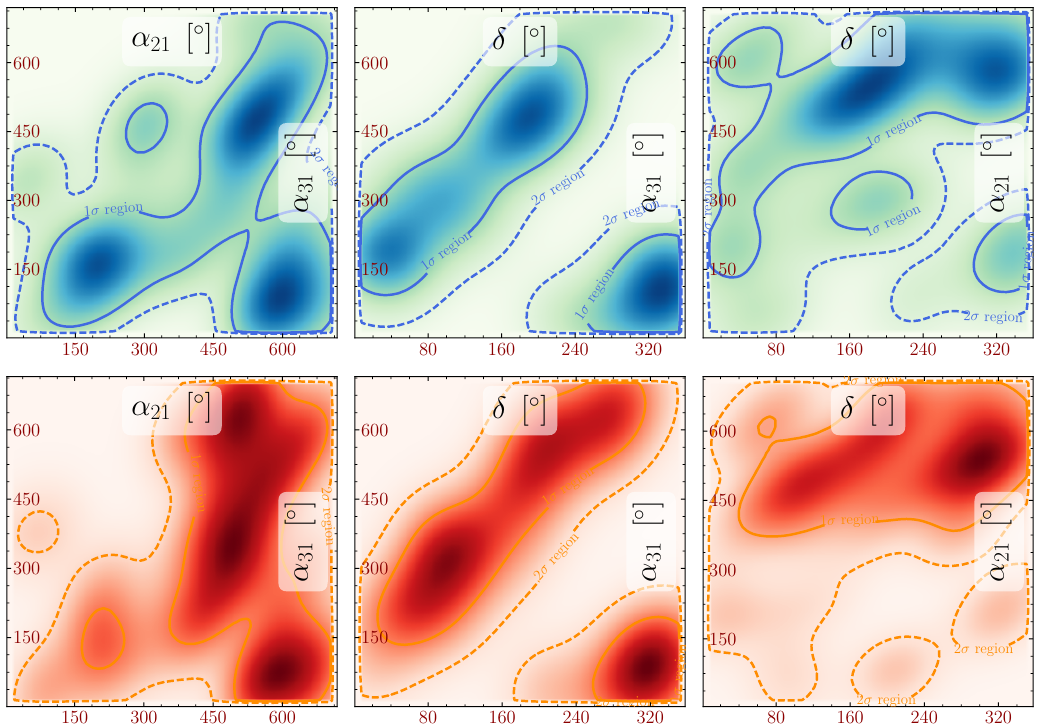
10 9 GeV with CP (cid:2)